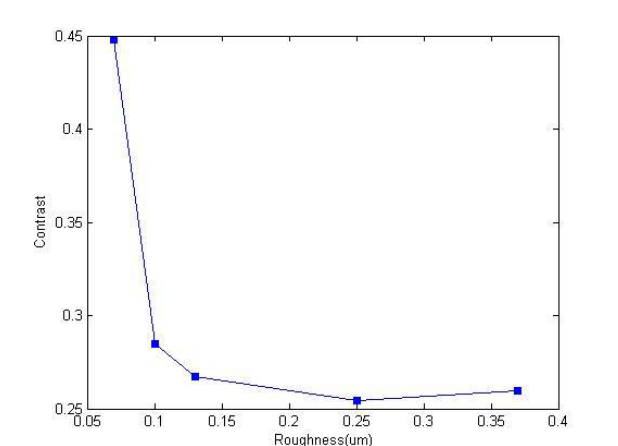
Fig. 4: The contrast of the intensities as a function of the roughness in (μm).